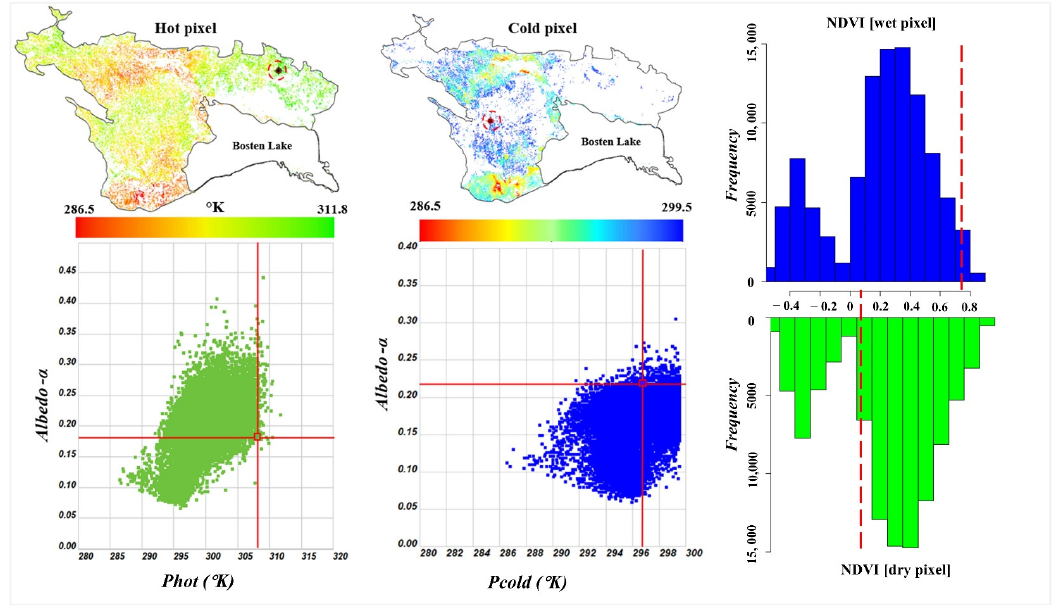
Figure 4. Model performance prototype of bivariate scatter plots, and histograms showing anchor pixels selection through NDVI, Ts (cold-dry), and surface albed o.